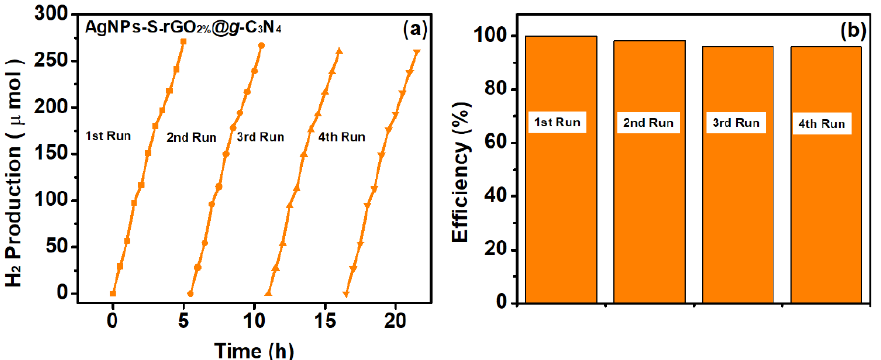
Figure 11. ( a , b ) Reusability and stability of AgNPs-S-rGO 2% @ g -C 3 N 4 for four consecutive cycles.